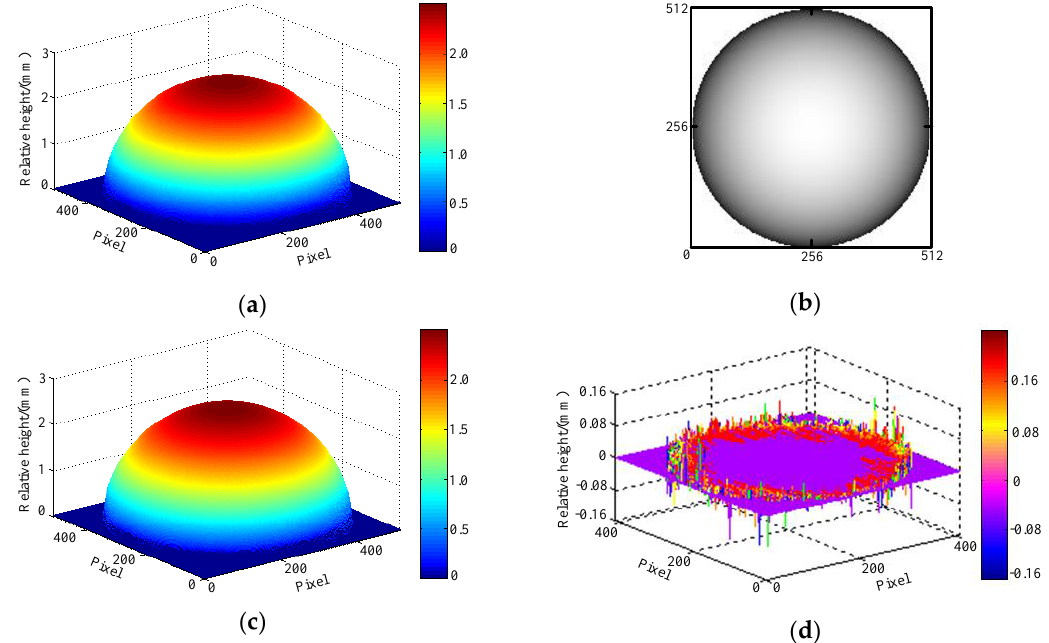
Figure 9. Simulation results of the semi-spherical surface: ( a ) Semi-spherical surface; ( b ) Synthetic image; ( c ) Reconstructed surface; and ( d ) Reconstruction error.